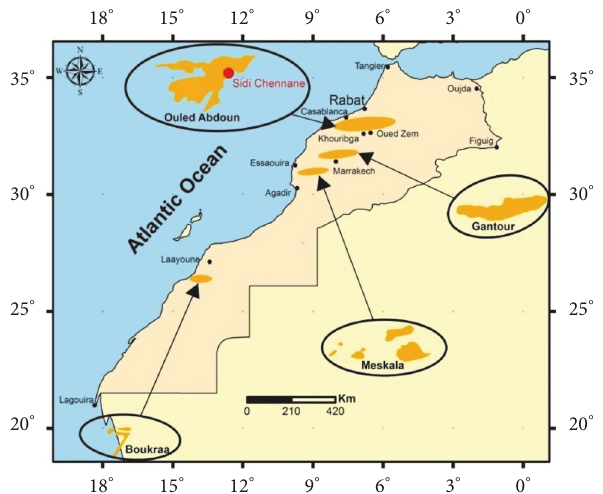
Figure 1: Main Moroccan phosphate basins. Sidi Chennane deposit location is highlighted with red color in Ouled Abdoun basin.